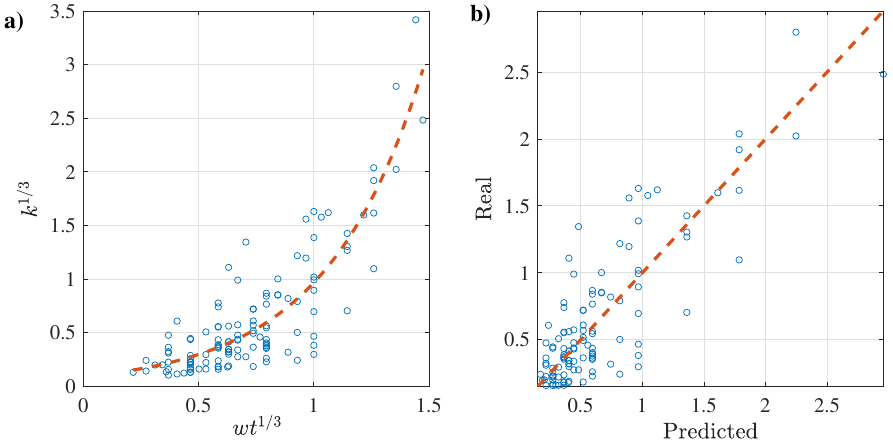
Figure 4. ( a ) k 1/3 vs. wt 1/3 best fitting results and ( b ) predicted vs. actual k 1/3